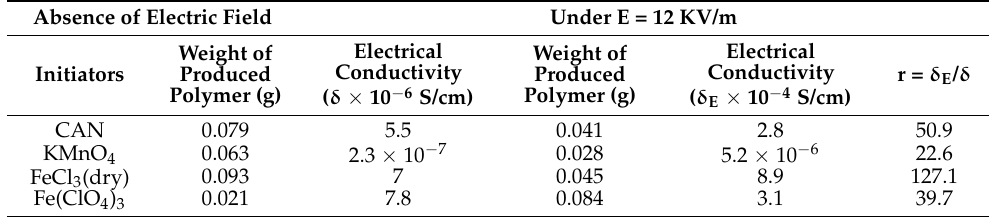
Table 1. Electrical conductivity of produced polycarbazole with different initiators and PTSA (1M) as the dopant in acetone, in absence and presence of 12 KV/m electric field after 3 h. Absence of Electric Field Under E = 12 KV/m Electrical Electrical Weight of Weight of Conductivity Conductivity Initiators Produced r = δ E / δ Produced Polymer (g) Polymer (g) ( δ × 10 − 6 S/cm) ( δ E × 10 − 4 S/cm) CAN